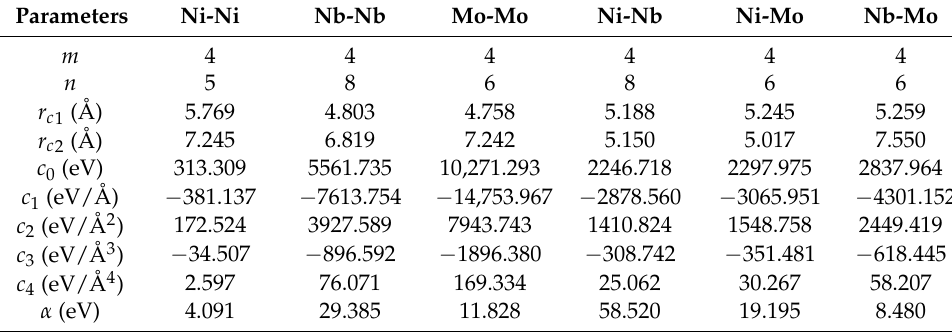
Table 1. The parameters of the constructed potential for the Ni-Nb-Mo system [55]. Parameters